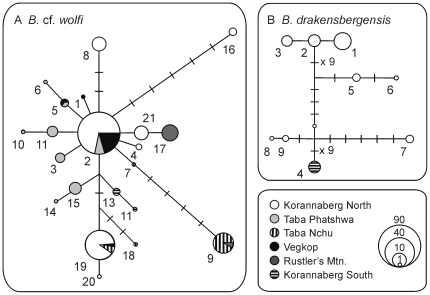
Haplotype networks.Statistical parsimony networks showing the evolutionary relations and geographic occurrence of (a) Branchipodopsis cf. wolfi and (b) Branchipodopsis drakensbergensis mitochondrial haplotypes numbered according to Table 1. Pie charts illustrate distribution and relative abundance of each haplotype on different inselbergs. Size of circles is proportional to the number of individuals included (bottom right). Perpendicular black dashes represent hypothetical intermediate haplotypes. The numbers of such dashes between two haplotypes indicates the number of mutational steps involved.